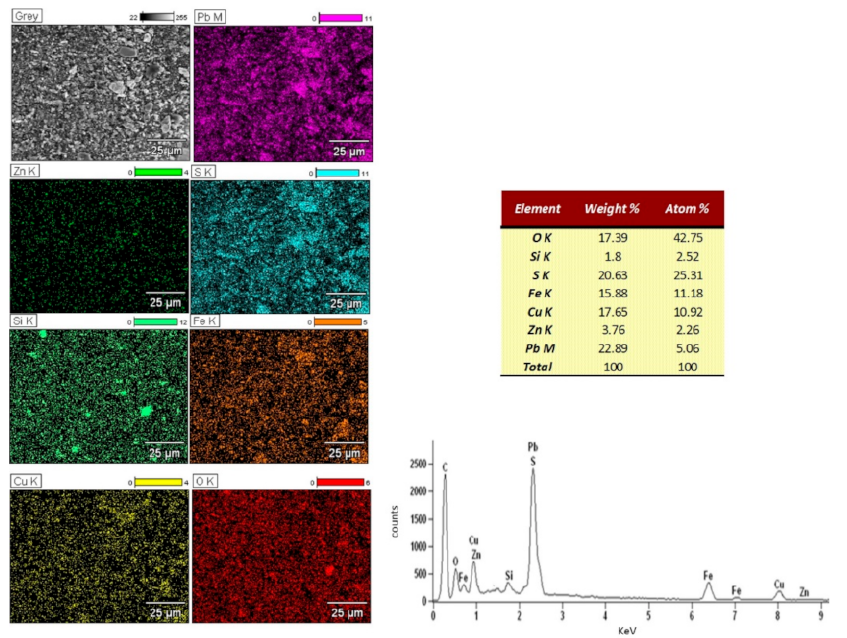
Figure 4. SEM-EDS mapping and microanalysis images for distribution of Pb, Zn, S, Si, Fe, Cu, and O in the lead